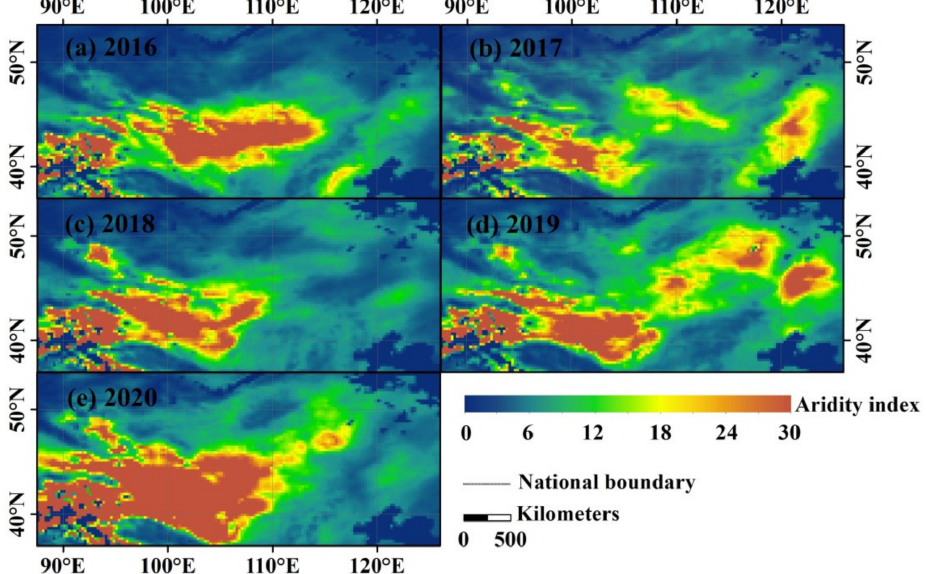
Figure 3. Spatial distribution of the average January to April aridity index over the MP and surround- ing areas during the period of 2016–2020. ( a ) 2016. ( b ) 2017. ( c ) 2018. ( d ) 2019. ( e )